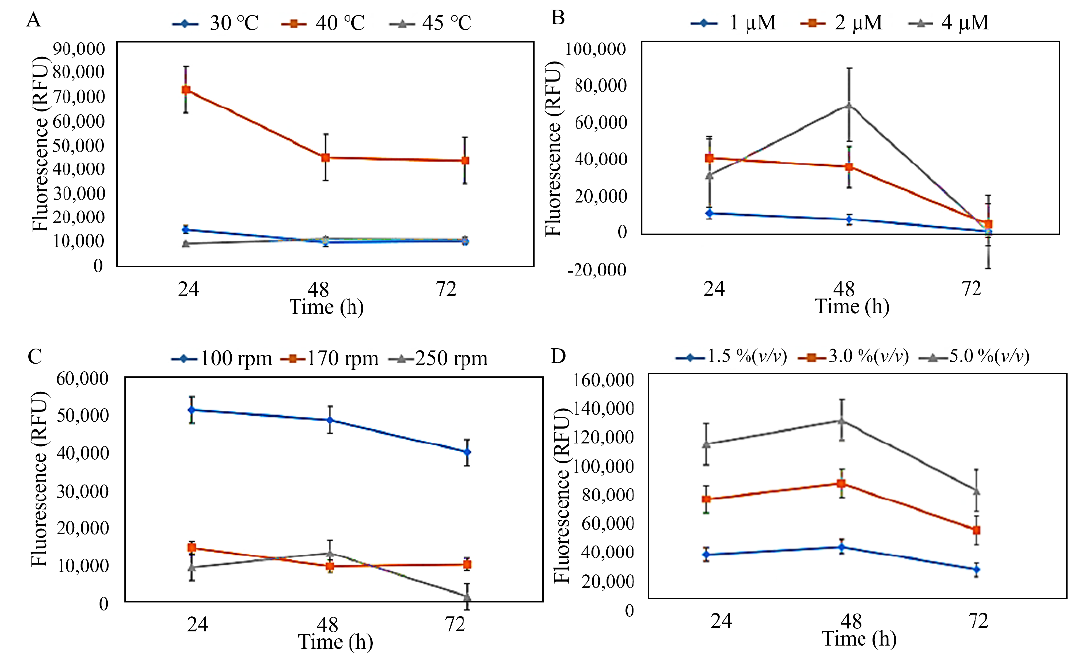
Figure 5. Identification of suitable culture parameters for PHA biosynthesis by A. calcoaceticus UMTKB-8 cultured in glycerol. ( A ). Effect of temperature on PHA production, ( B ). effect of MgSO 4 ·7H 2 O concentration on PHA production, ( C ). effect of agitation on PHA production, ( D ). effect of inoculum concentration on PHA production.